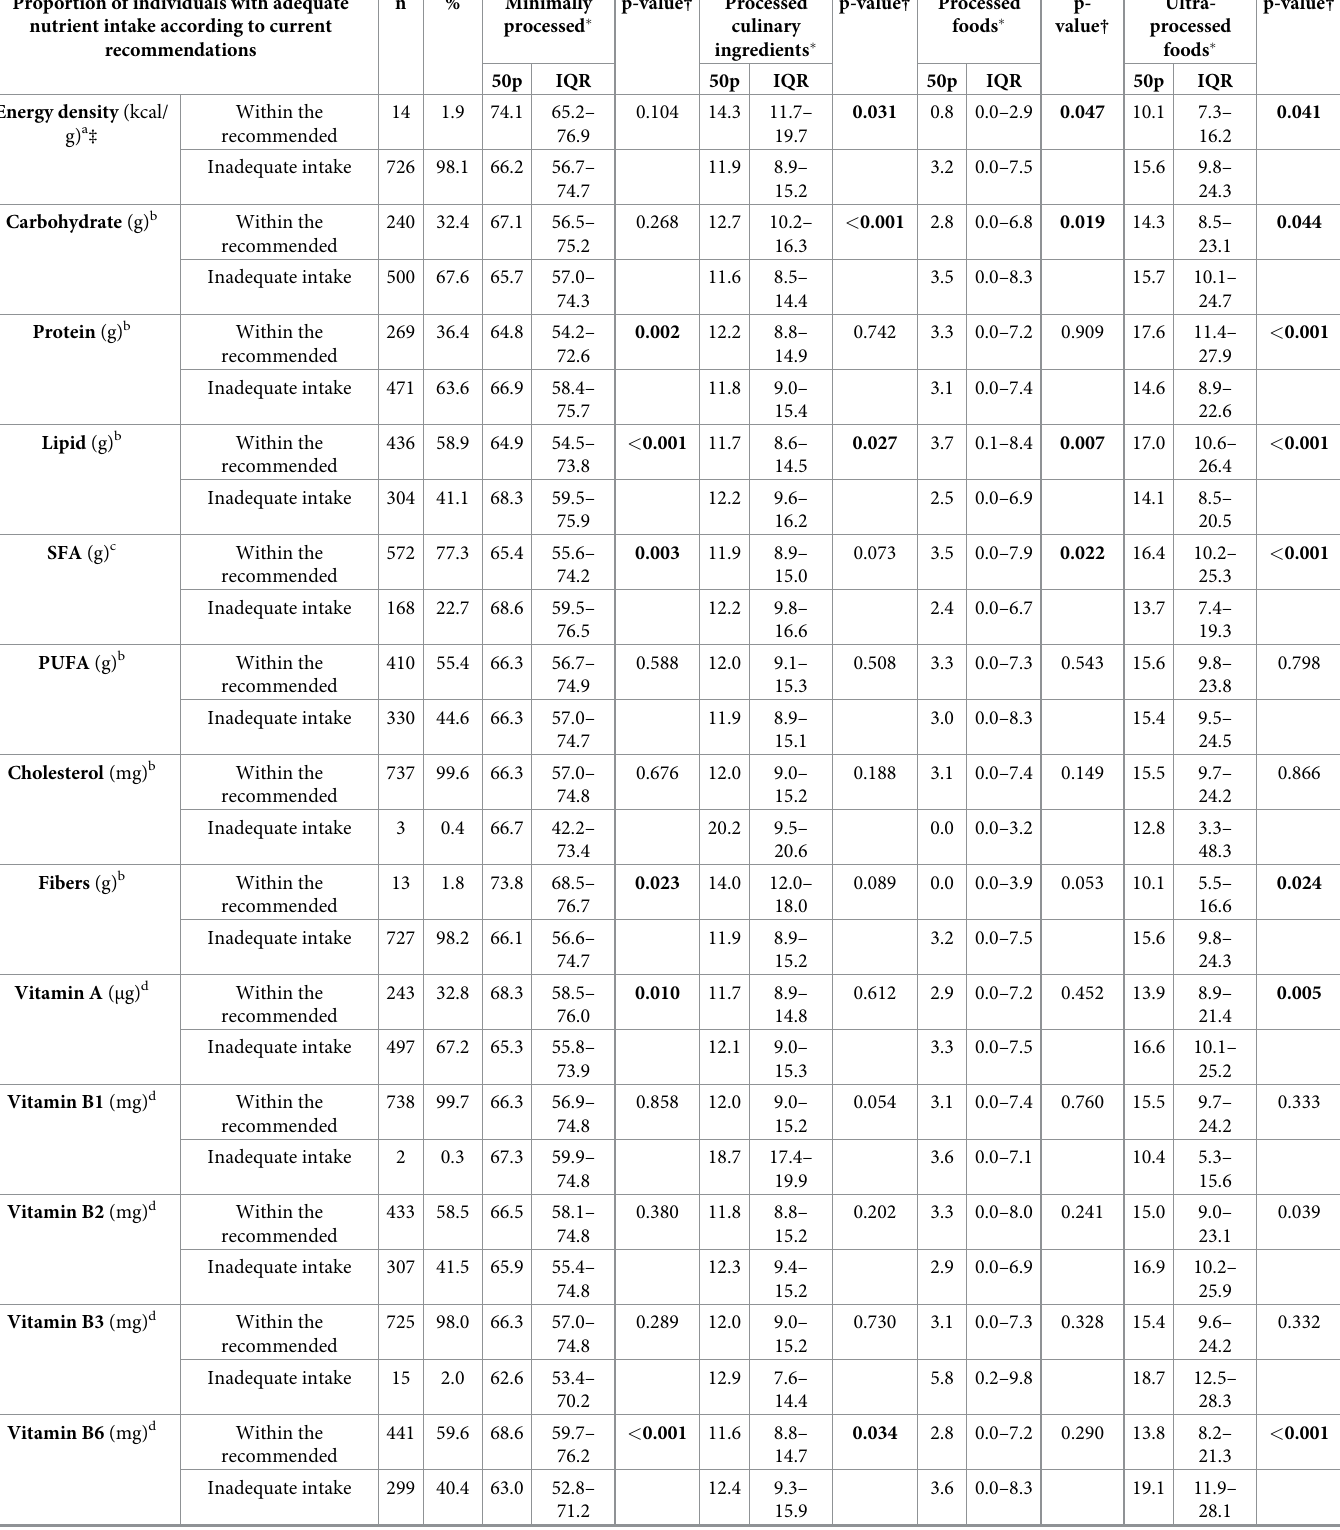
Table 3. Proportion of individuals with adequate nutrient intake and the caloric contribution of minimally processed foods, processed culinary ingredients, pro- cessed foods and ultra-processed foods. Proportion of individuals with adequate nutrient intake according to current